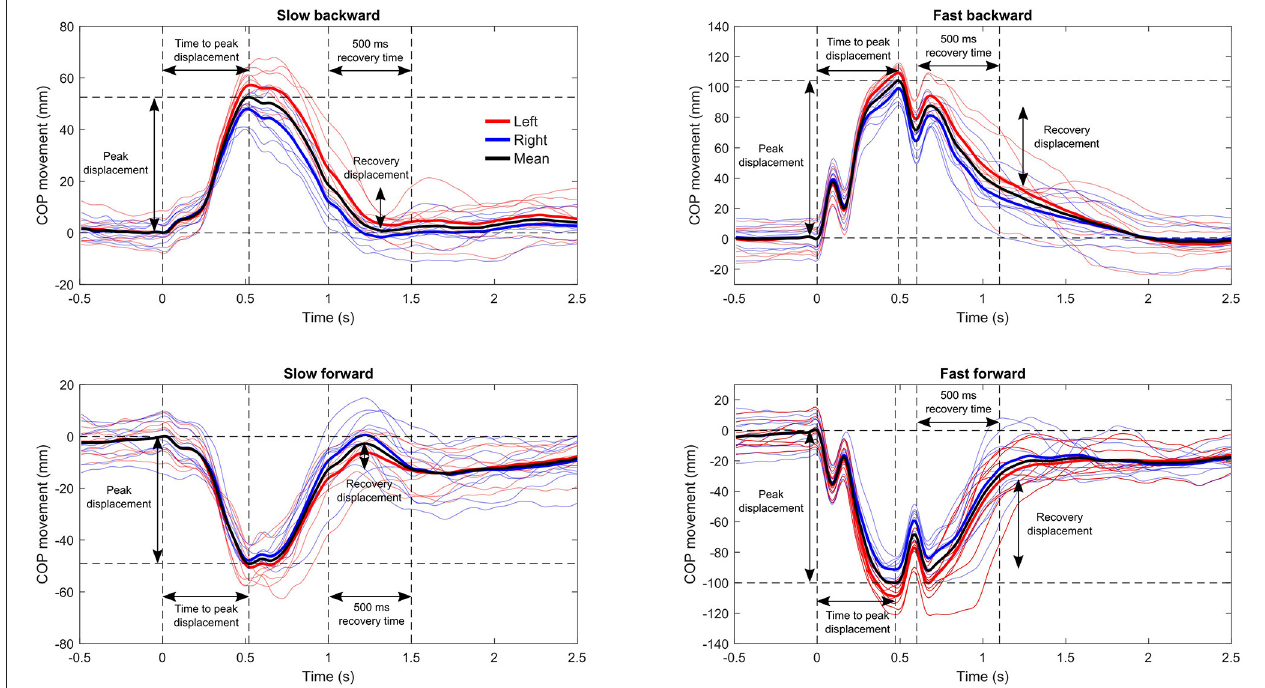
FIGURE 2 | Example of the center of pressure (COP) trajectories relative to the belt during the four perturbation protocols from a single participant on a single session. The thin lines represent the response to each perturbation, and the thick lines are the ensemble average trajectory for each leg. The outcome measures were calculated from the ensemble average trajectory of both legs (black) and alternatively from each response to perturbation separately (average of right and left legs) with subsequent averaging of the results to obtain the final outcome. The horizontal dashed lines denote the peak displacement and the zero displacement level, and the vertical lines mark the instance of perturbation onset, time at peak displacement, and 500-ms post peak displacement for the calculation of recovery